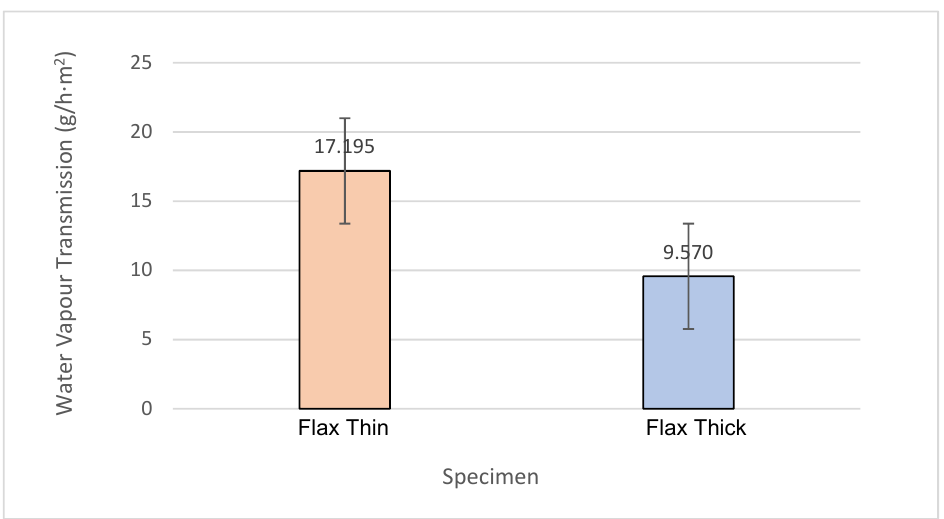
Figure 11. Average water vapour transmission of honeycomb structures.